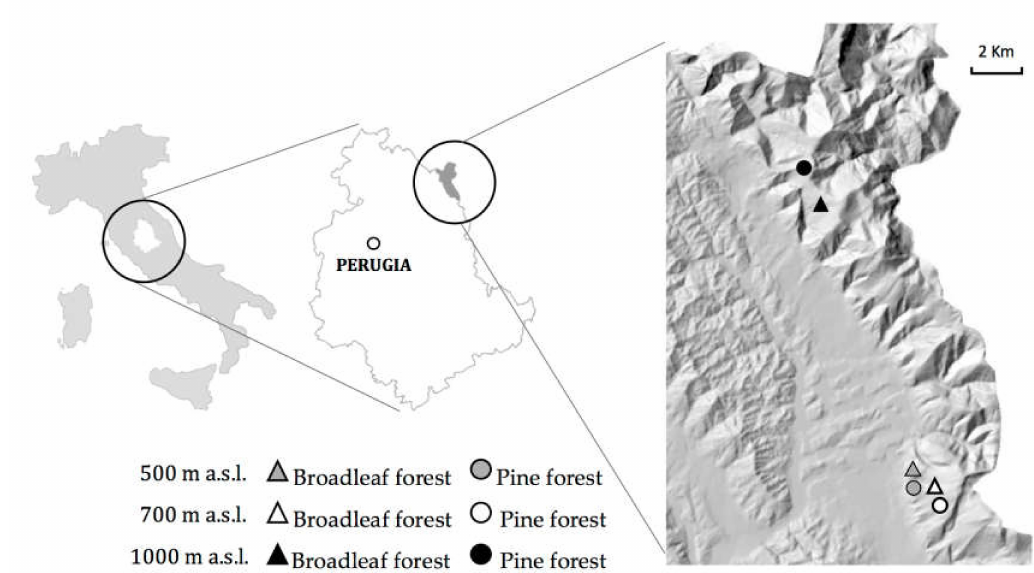
Figure 1. Map of Italy with magnification of the Umbria region and indication of the study